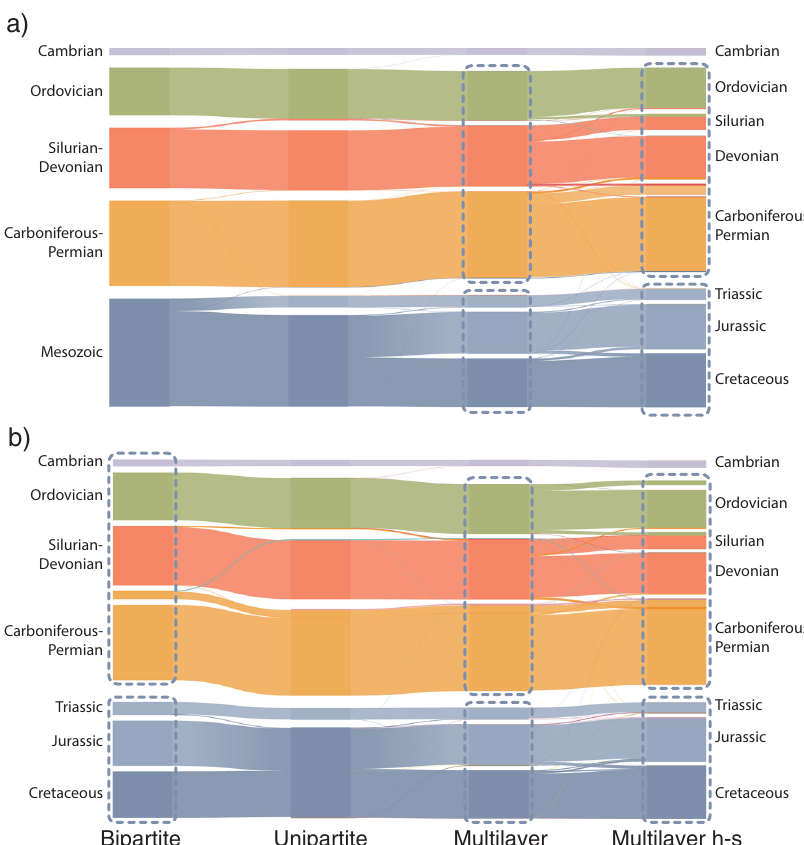
Fig. 6 Alluvial diagrams of optimised partitions for the hypergraph of fossil data represented with different networks. Darker bars represent the modules in each partition, with height proportional to the fl ow volume of the contained nodes. Streamlines connect modules that contain the same nodes. Lazy walks in a and non-lazy walks in b . We show top modules when a partition lacks deeper levels and leaf modules marked with dashed lines when they exist. Module names from the geological period or era represented by the fauna assemblage. Modules belonging to the Mesozoic era in blue, Carboniferous – Permian in orange, Silurian – Devonian in red, Ordovician in green and Cambrian in purple. h-s Table 3 Optimised fl ow-based multilevel communities of the hypergraph of fossil data represented with different networks. Representation Nodes (×10 3 ) Links (×10 3 ) Modules Codelength (bits) Time (hh:mm:ss) Top Leaf Levels Overlap Lazy Bipartite 13